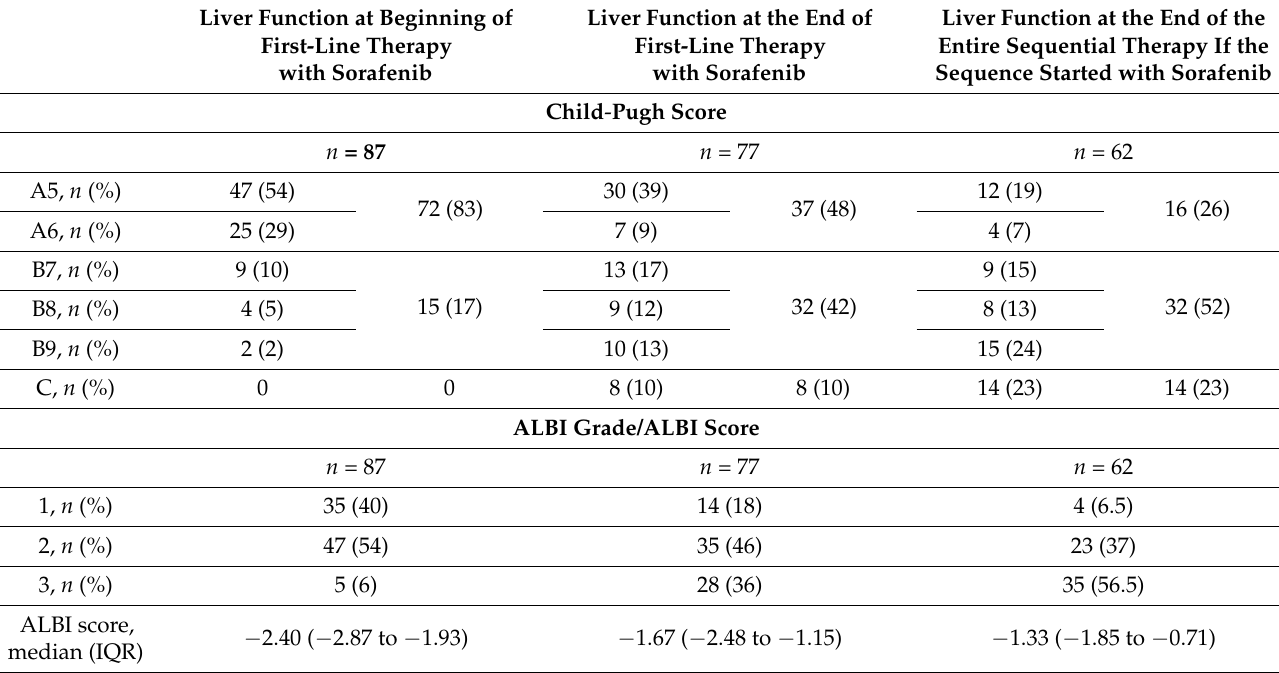
Table 4. Liver function before and after first-line therapy with sorafenib or lenvatinib and at the end of the entire treatment sequence (deviations from 100% are due to